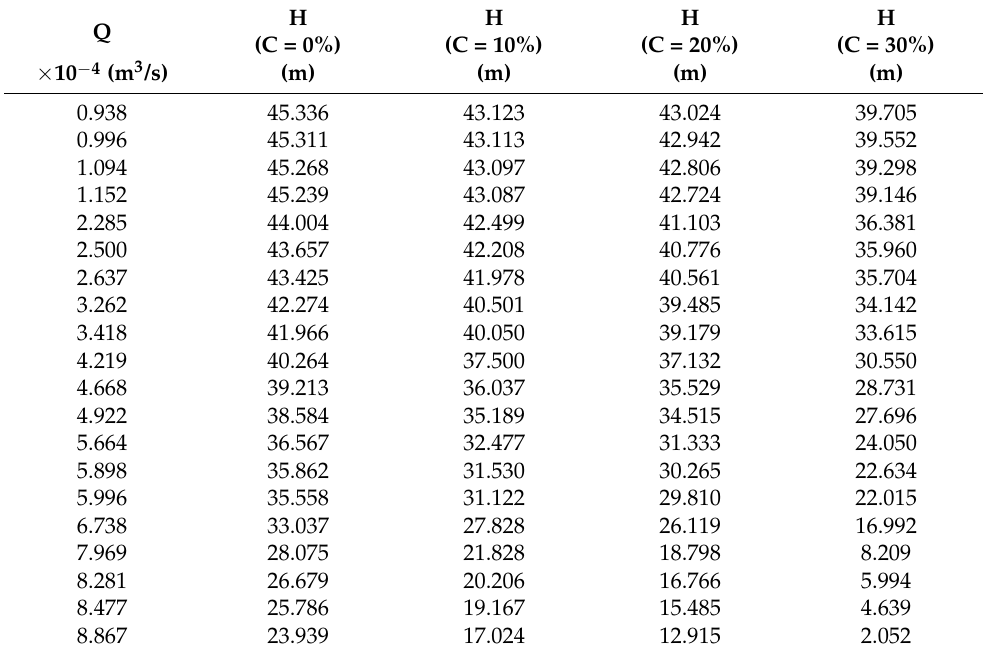
Table 2. Q-H data at different ice